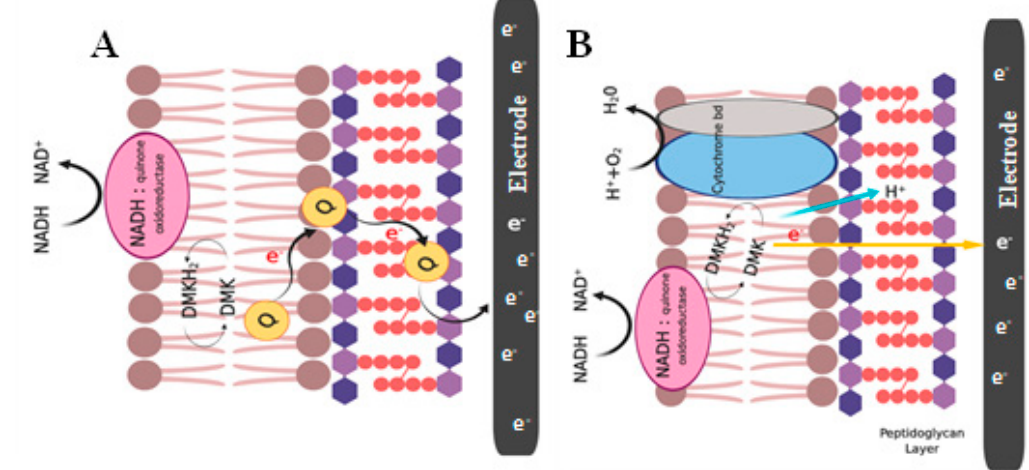
Fig. 3. Schematic representation of EET mechanism of Gram-positive bacteria Enterococcus faecalis via ( A ) NADH oxidoreductase, quinine act as a self - generated mediators which transport electrons through outer thicker peptidoglycan layer to the electrode where cytochrome bd oxidase enzyme was not involved; ( B ) EET pathway through the presence of cytochrome bd in the lipid bilayer without the use of endogenous mediators [Sources: Pankratova et al .,